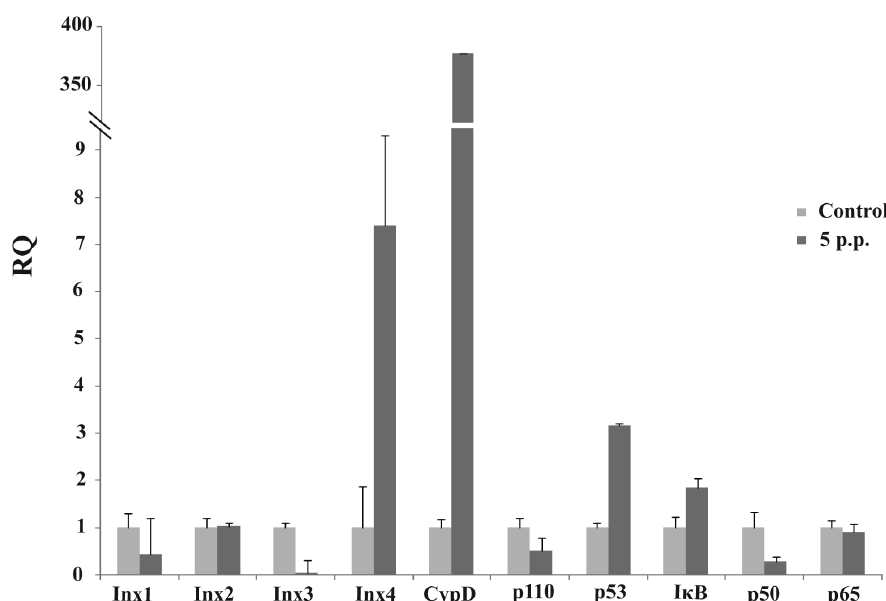
Figure 1. qRT-PCR detected key genes in five signaling pathways with hemocytes 5 days post-parasitization (p.p.).